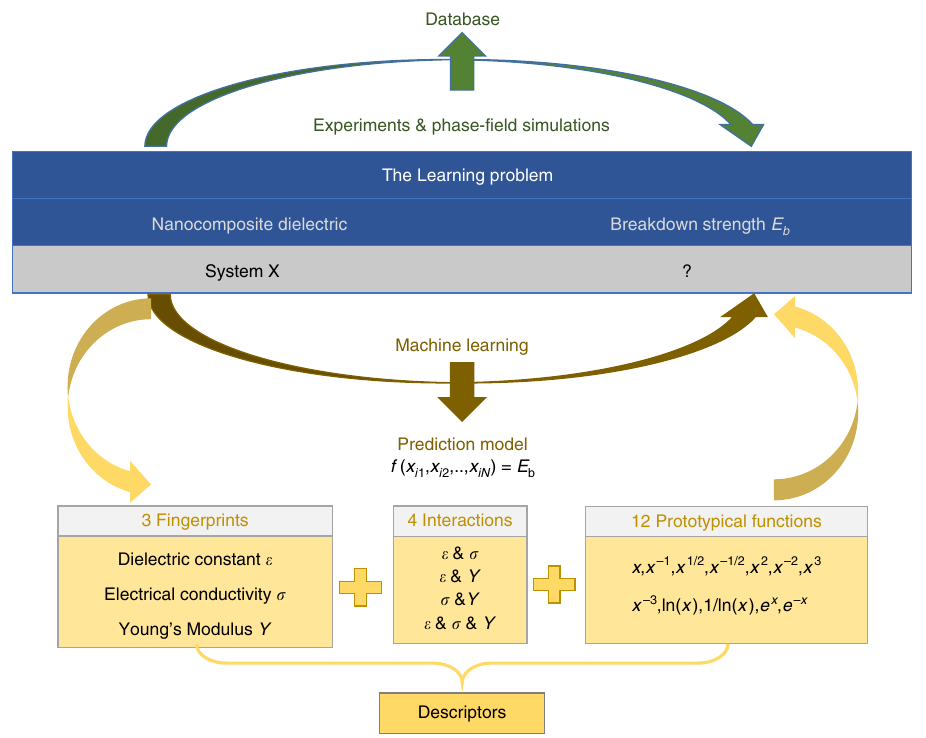
Fig. 5 Machine learning strategy. Schematic work fl ow of the machine learning strategy for producing an analytical expression for the breakdown strength of poly(vinylidene fl uoride-hexa fl uoropropylene) (P(VDF-HFP))-based nanocomposites from the breakdown strength database generated by the high- throughput phase- fi eld simulations. In the machine learning process, 3 fi ngerprints, 4 interactions, and 12 prototypical functions are employed to perform least-squares regressions and